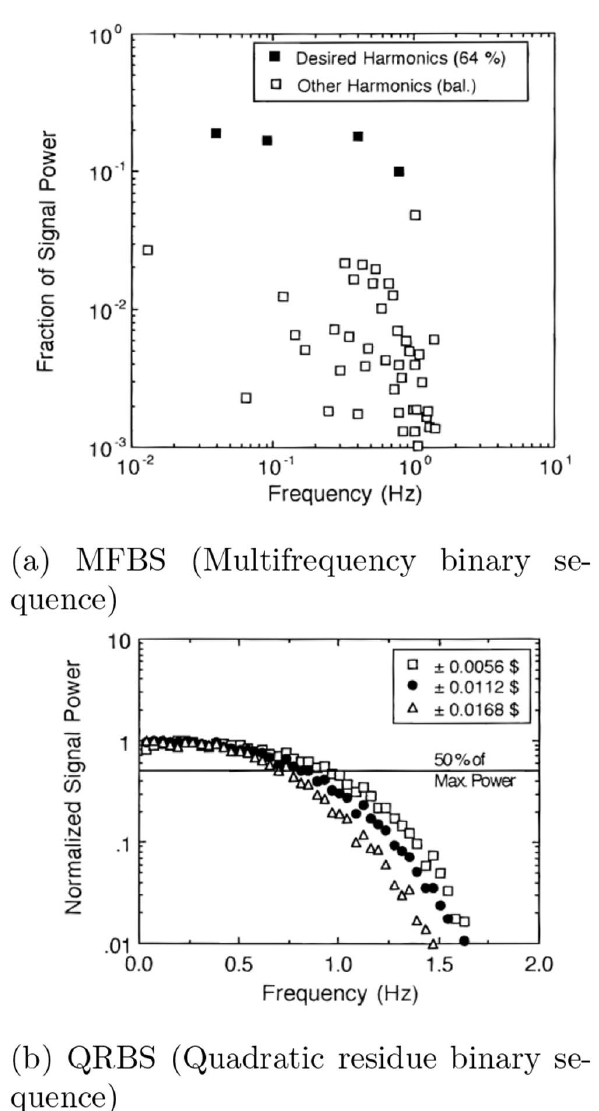
Fig. 6. Power spectra of pseudo-random binary reactivity mod- ulations in Experimental Breeder Reactor-II (Argonne National Laboratory, 1999